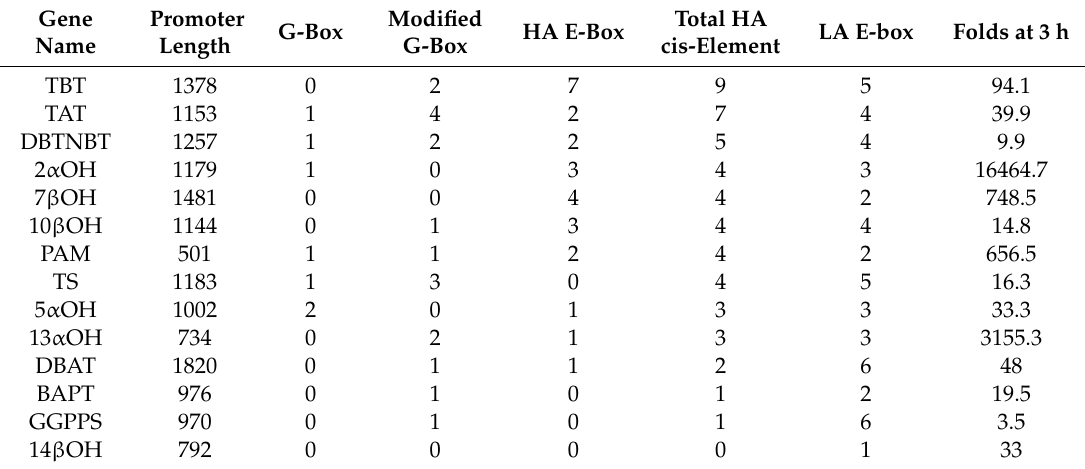
Table 6. List of cis-element analysis information in the paclitaxel biosynthesis pathway gene promoter sequence.